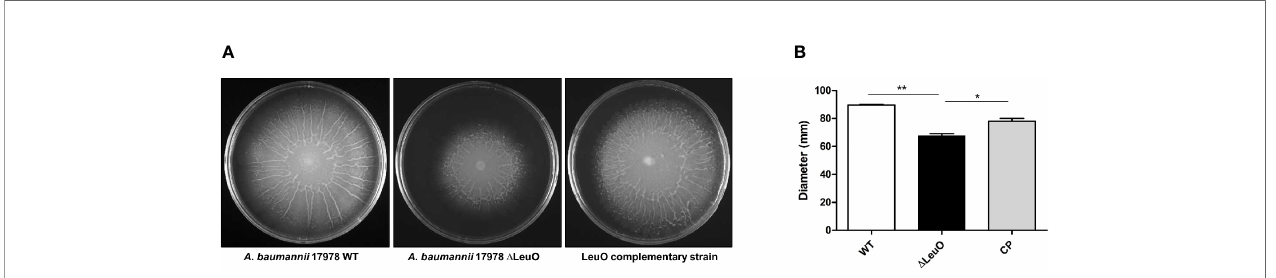
FIGURE 5 | Comparison of surface motility of A. baumannii 17978 WT, D LeuO, and complementation strains. (A) 0.3% Eiken soft agar plates were used to test the surface motility of A. baumannii strains. Migration of bacteria from the inoculation point was photographed after culturing at 37°C for 10 h. (B) Average area of migration (diameter in mm) of three biological replicates is presented with standard deviation. The experiment was performed in triplicates. *P < 0.05, **P < 0.01, signi fi cantly lower than that of the wild-type strain.